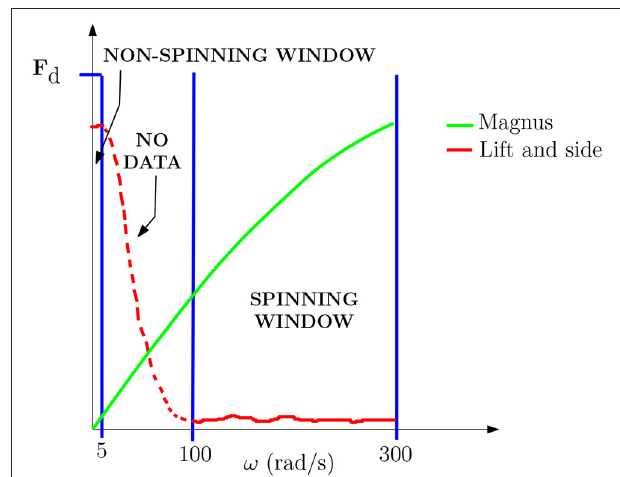
FIGURE 1 | Scheme of the maximum value of lift, side and Magnus forces when varying the angular velocity ω for a given speed V . The y − axis is scaled according to the maximum drag force for the considered velocity. The curves for lift, side and Magnus forces are drawn according to experimental data [8–10]. The missing curve for lift and side forces between spinning and non-spinning windows is because there are no data reported in such